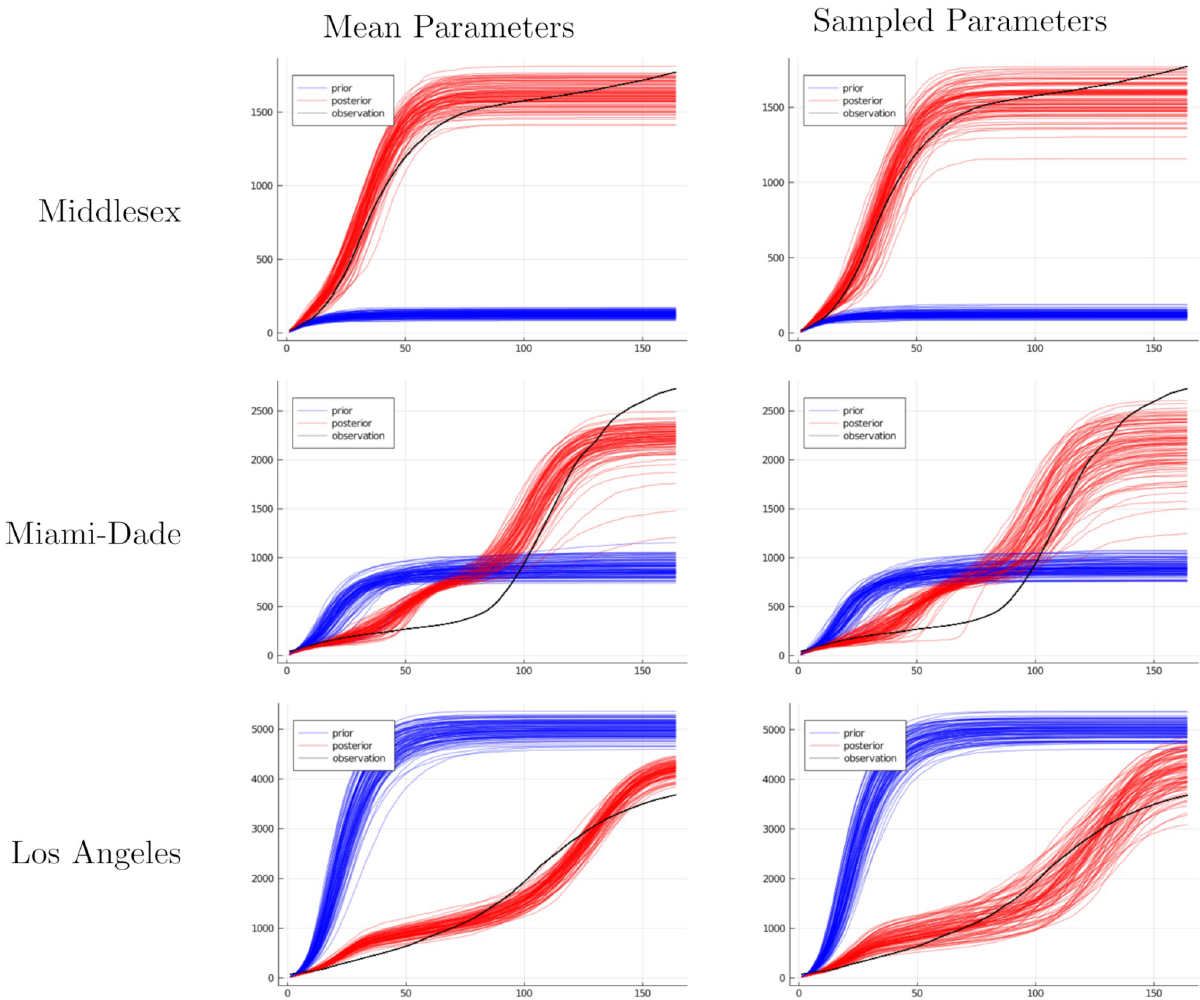
Fig 1. Cumulative infection trajectories using fixed or sampled disease parameters. After fitting the parameters of our model to data, we show the cumulative infections produced by 100 runs of the simulator using selected parameters. On the left, we use the posterior mean parameters; the observed variation comes from the untraced randomness of network simulator. On the right, we use samples from the posterior distribution; variation comes from both the untraced randomness and the variance of our posterior distribution.